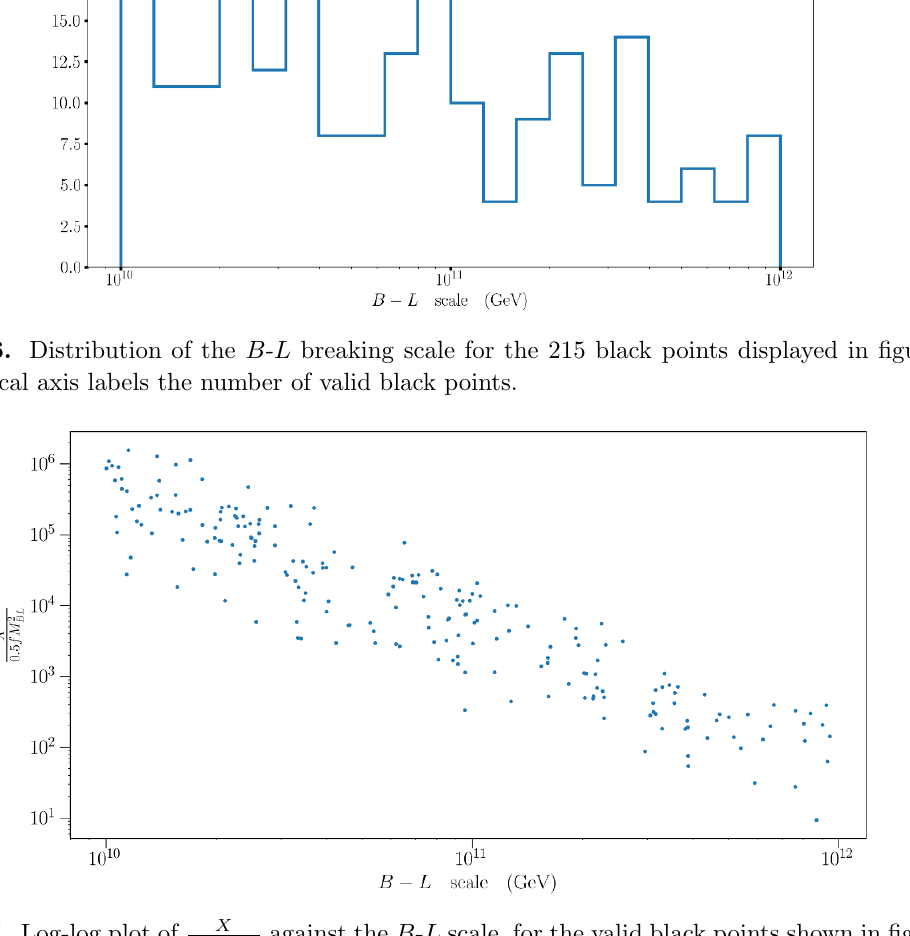
expresses the degree 1 fM 2 BL 2